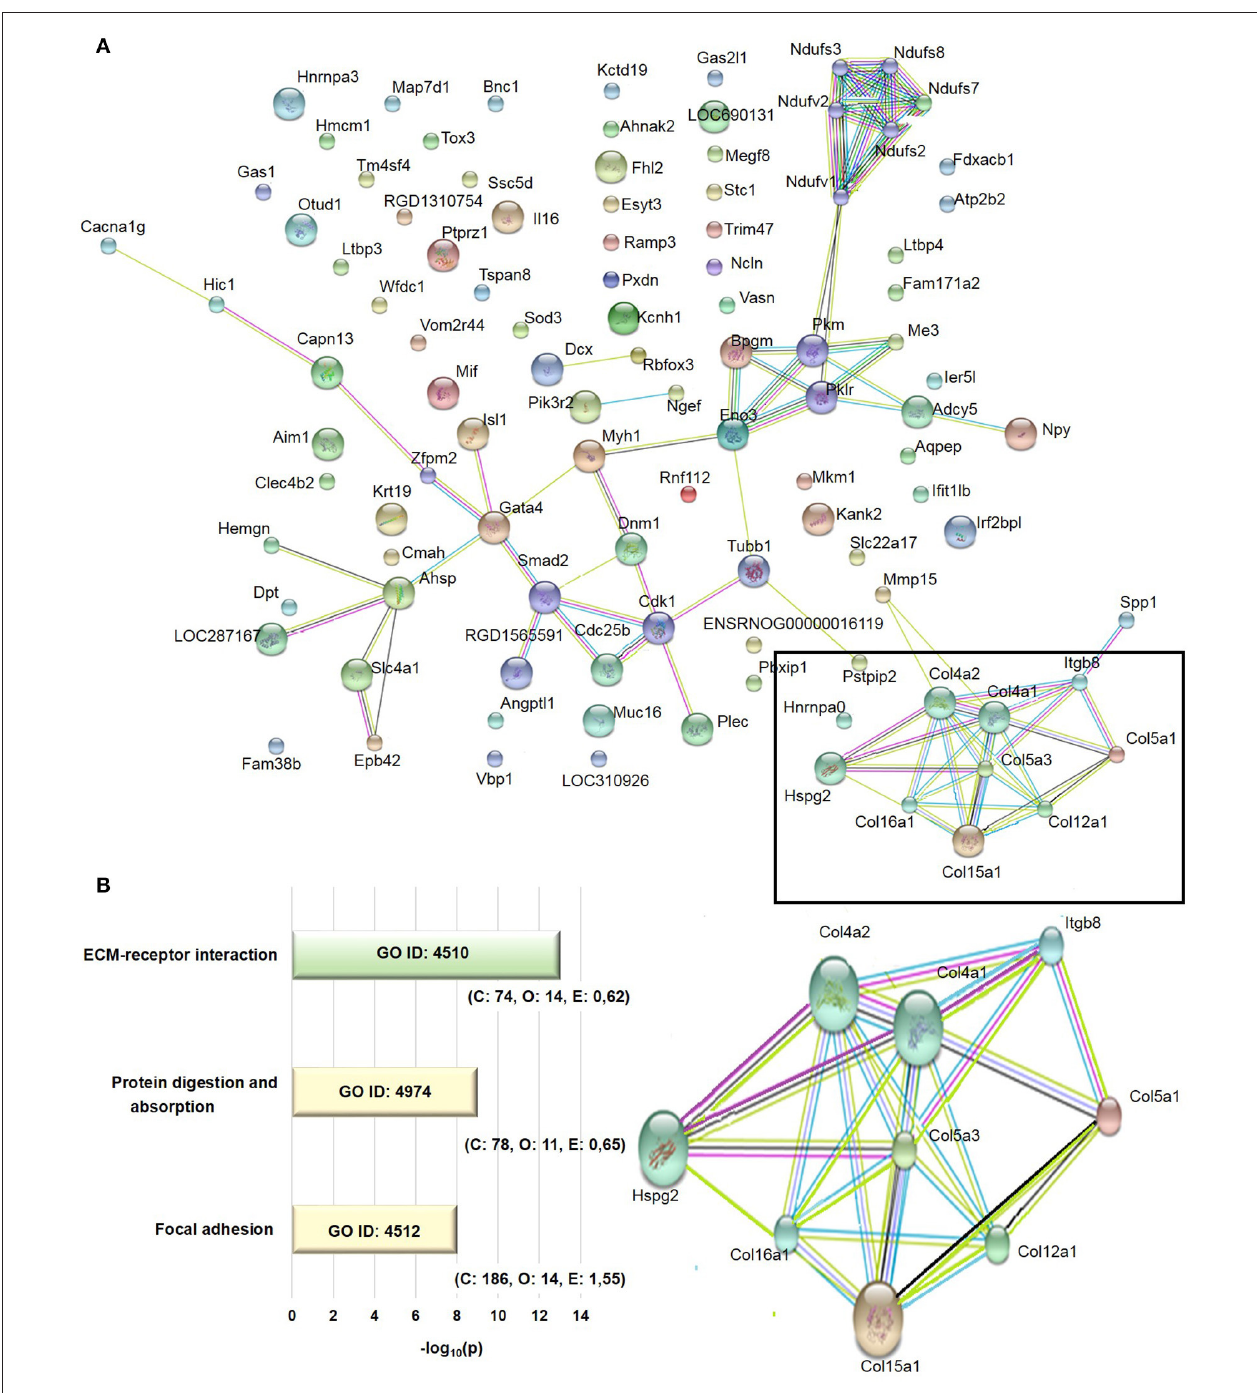
FIGURE 7 | Transcriptome analysis of periepididymal adipose tissue. (A) Identification of network interactions of differentially expressed genes between C and AGE-albumin-treated animals. Bioinformatic analysis of RNA-seq data were performed by DeSeq2 Version 3.5, GO, GSEA and compared to STRING 9.0, using an interaction score 0.400 - medium confidence. Signal p -value > 0.1, fold change < 0.04, micro-RNA and pseudogenes were excluded. (B) The extracelullar matrix-receptor interaction (ECM-receptor interaction), protein digestion and absorption and focal adhesion were obtained by gene ontology (GO) enrichment analysis. Number of reference genes in the category (C), number of genes in the set and also in the category (O) and the expected number (E) in the category were observed after p -value cutoff of < 0.01 and fold-change > 0.4 adjusted. Adjusted p (AdjP) were converted in –log10 with variation between 8 and 13.